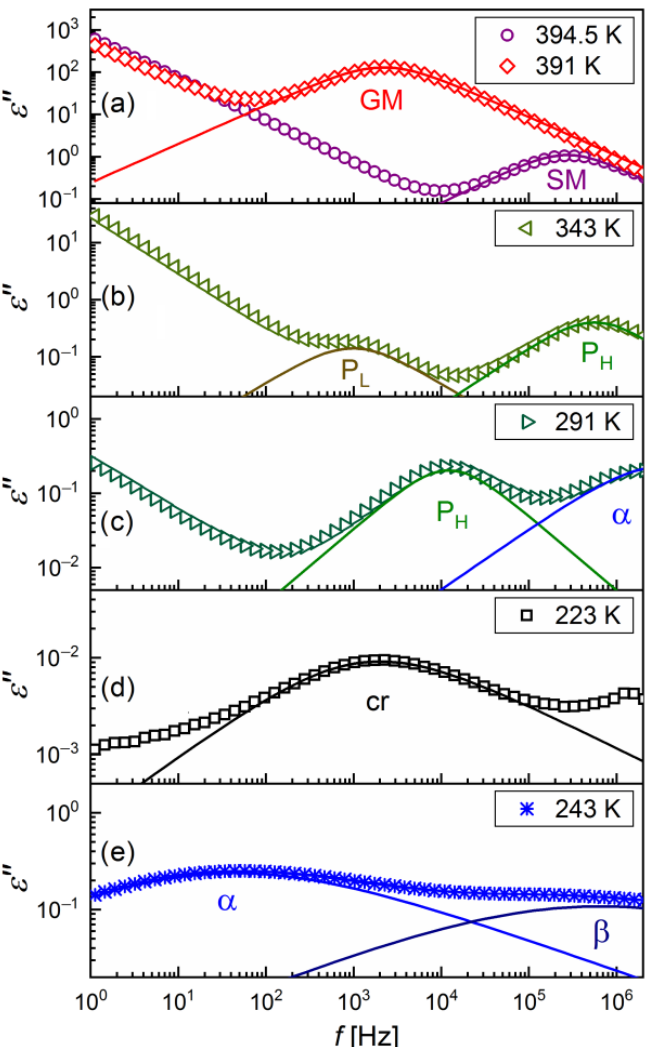
Figure 4. Representative dielectric spectra of 7HH6 (absorption part) measured on slow cooling ( a – d ) and on heating after fast cooling ( e ). The lines are fitting results of Equation (1) for each relaxation process, with omitted conductivity contribution. The presented phases are SmA * at 394.5 K, SmC * at 391 K ( a ), SmC A* at 343 K ( b ), 291 K ( c ), 243 K ( e ), and Cr1 at 223 K ( d